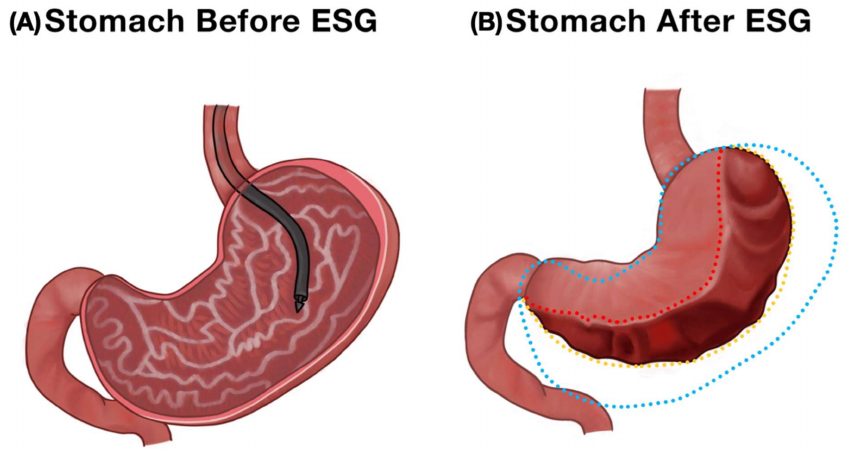
Figure 2. Endoscopic appearance of the stomach before and after endoscopic sleeve gastroplasty. ( A ) Normal stomach. ( B ) A reduced gastric volume after transmural suturing in